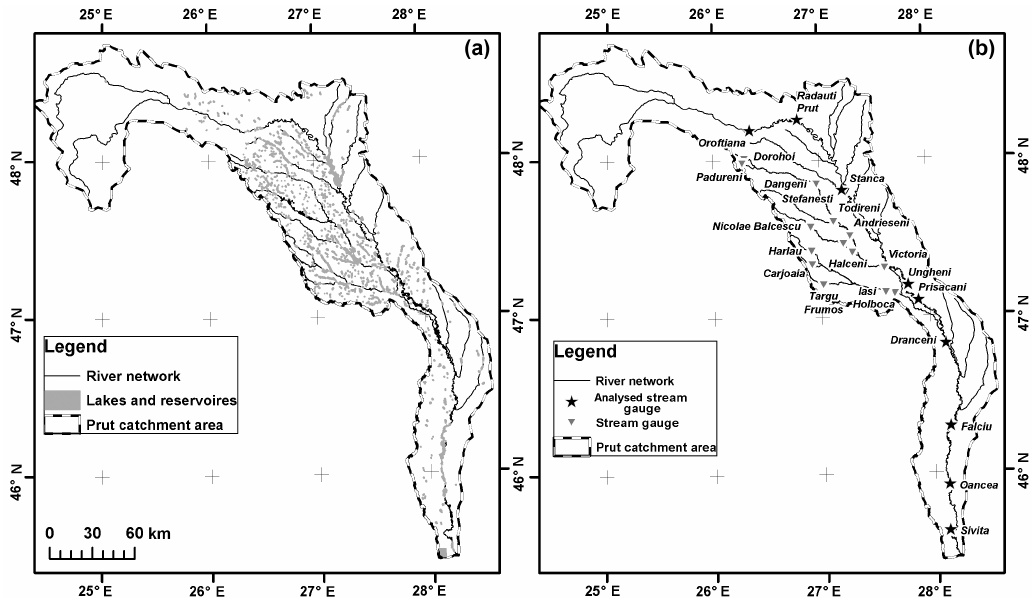
Figure 3. Main tributaries, reservoirs (left), and gauging stations (right) in the Prut River